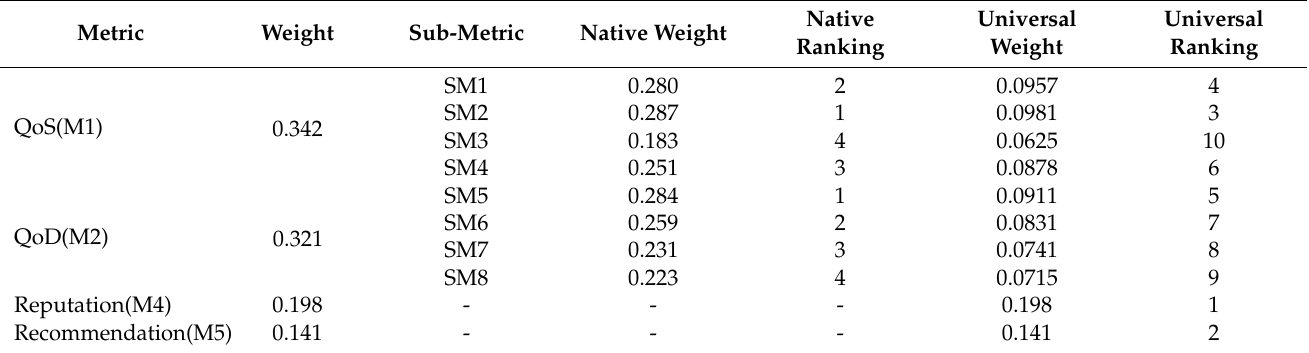
Table 19. Summary for the evaluation of trust metric for case 1.